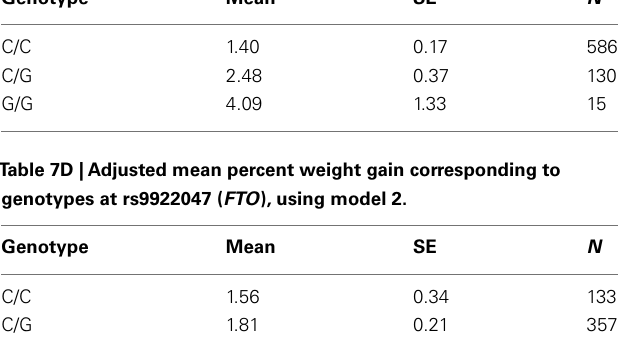
Table 7C |Adjusted mean percent weight gain corresponding to genotypes at rs13269119 ( SLC30A8 ), using model 2. Genotype